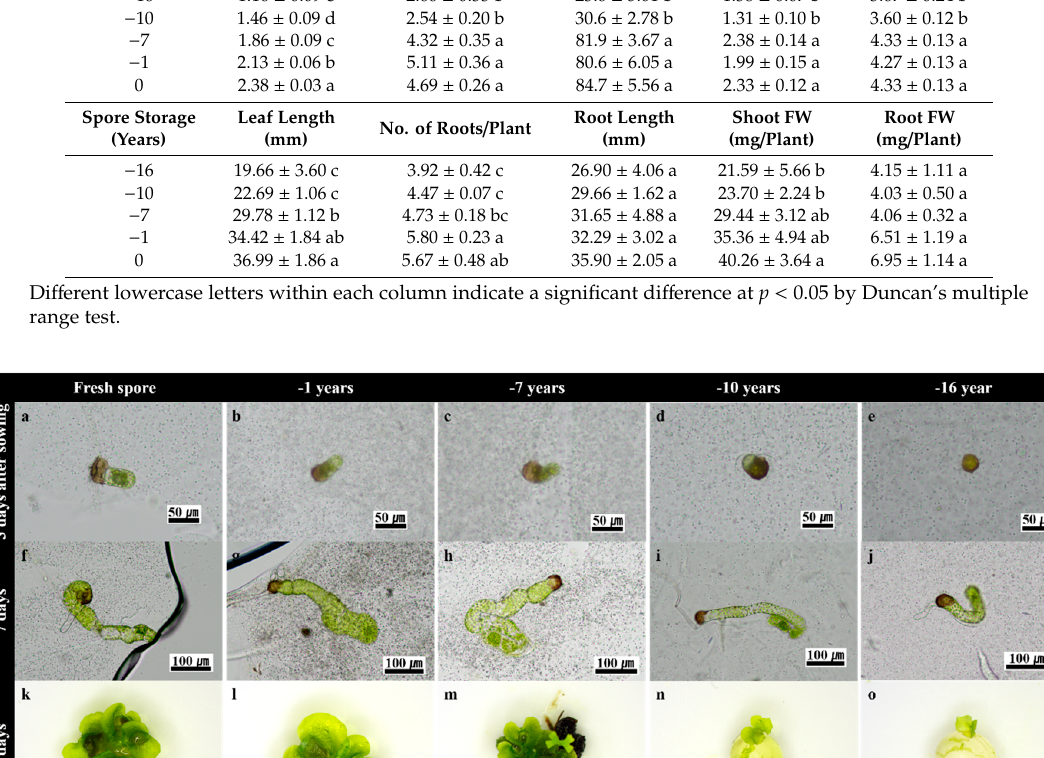
Different lowercase letters within each column indicate a significant difference at p < 0.05 by Duncan’s multiple range test.